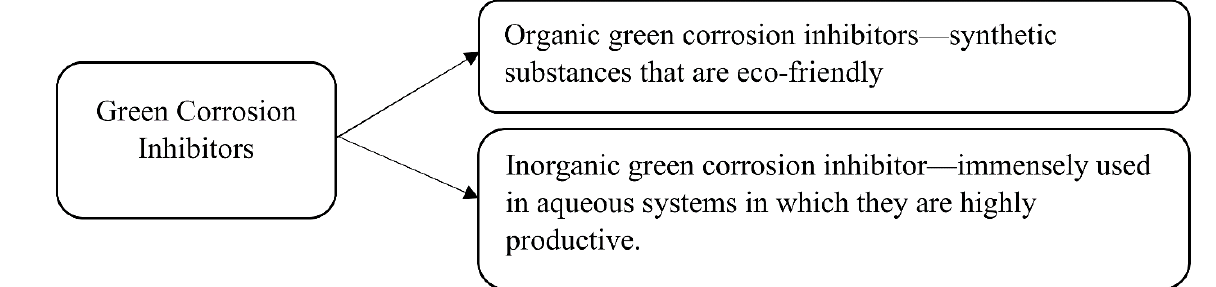
Figure 4. Classification of green corrosion inhibitors.